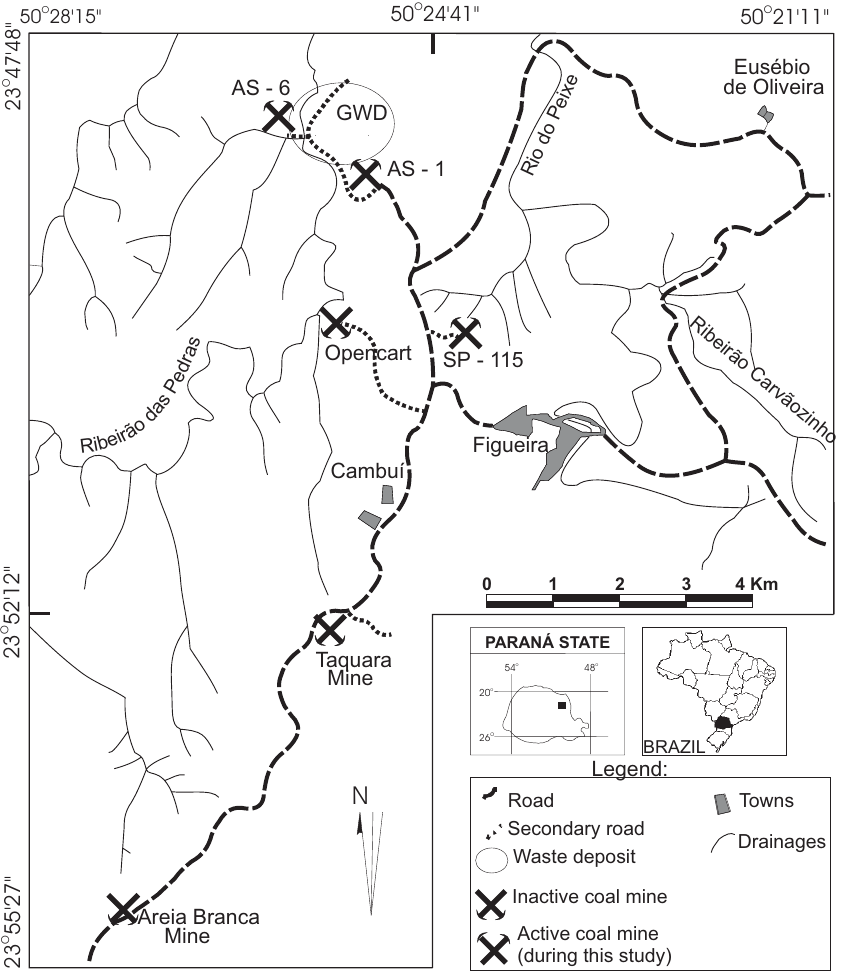
Fig. 1 – Map of the Figueira region, Paraná State, showing locations of the Amando Simões mine (AS-1 andAS-6) ,the Slope Plan mine 115 (SP-115) and the General waste deposit (GWD). Source: Carta do Brasil 1970 – IBGE – Folha Figueira,